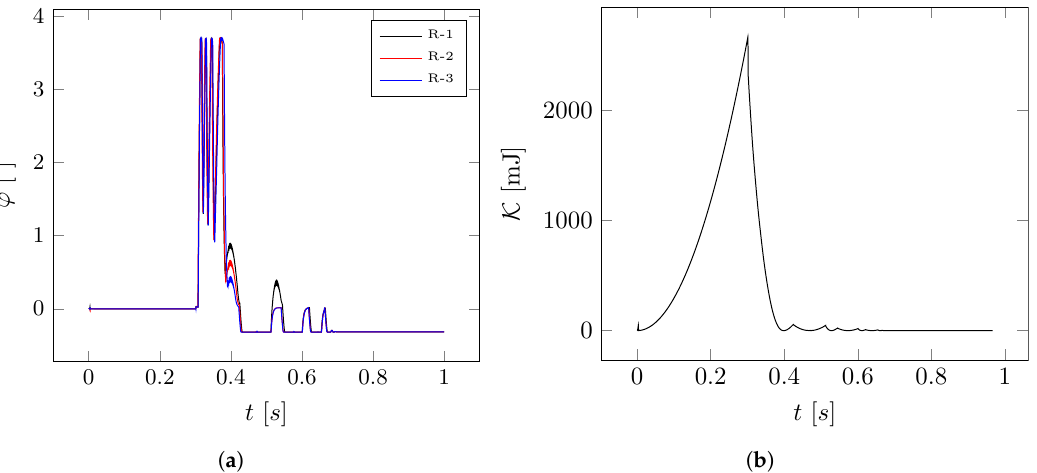
Figure 9. ( a ) The rotation evolution of each of the ratchet-structure joint; ( b ) the kinetic energy evolution over time of the lander